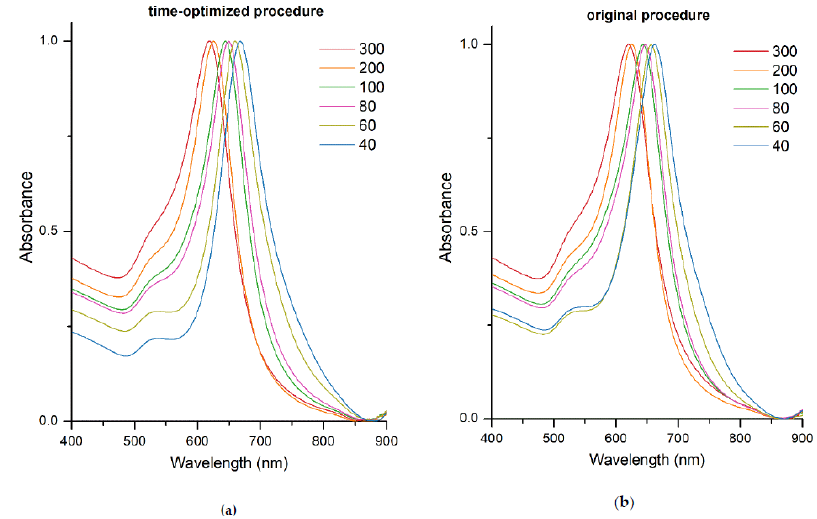
Figure 7. UV–VIS spectra of purified gold nanotriangles synthesized after time-optimized ( a ) and after original procedure ( b ). The legends indicate the volume ( µ L) of intermediate seeds used for each sample.